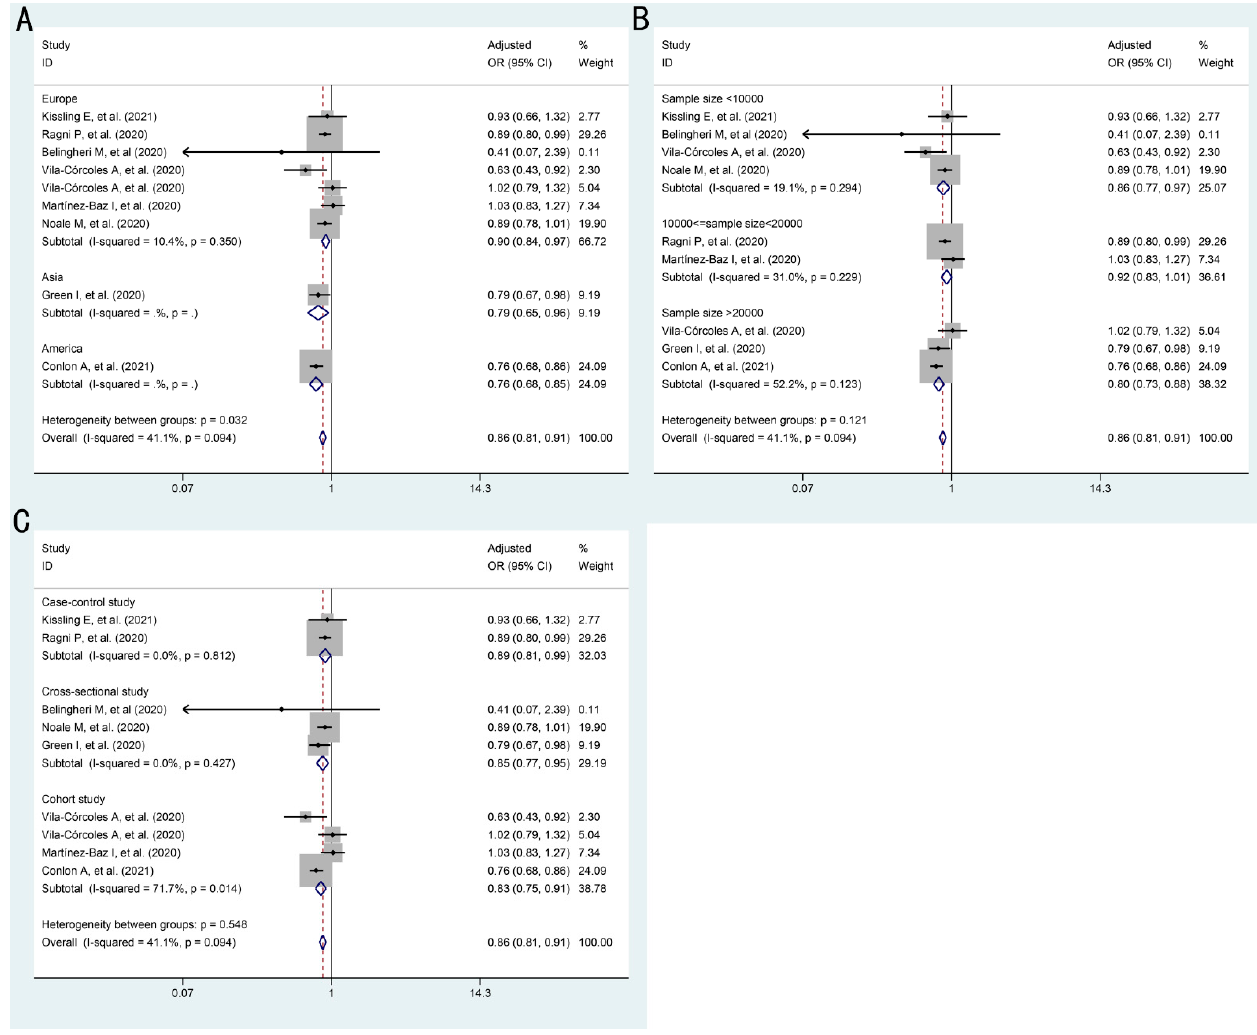
Figure 3. Forest plots for subgroup analysis on the association between influenza vaccination and SARS-CoV-2 infection by fixed effects model: ( A ) stratified by region ( B ) stratified by sample size ( C ) stratified by study design.